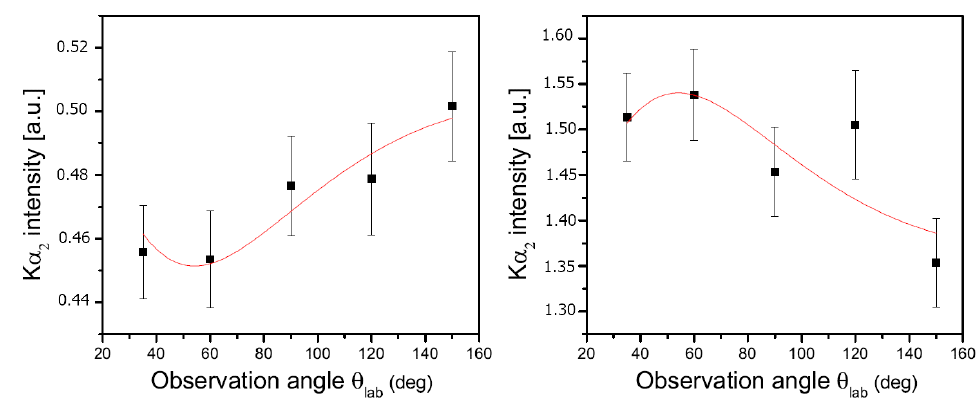
Figure 3. Angular distributions of K α 2 line intensity measured for K-shell excitation of He-like uranium in collisions with argon ( left ) and hydrogen ( right ) targets at 218 MeV/u. In addition, fits of Equation (1) to the experimental data are shown by solid lines. The clear change of shape between the two targets is due to the contribution of the electron-impact excitation (EIE) process. For details see